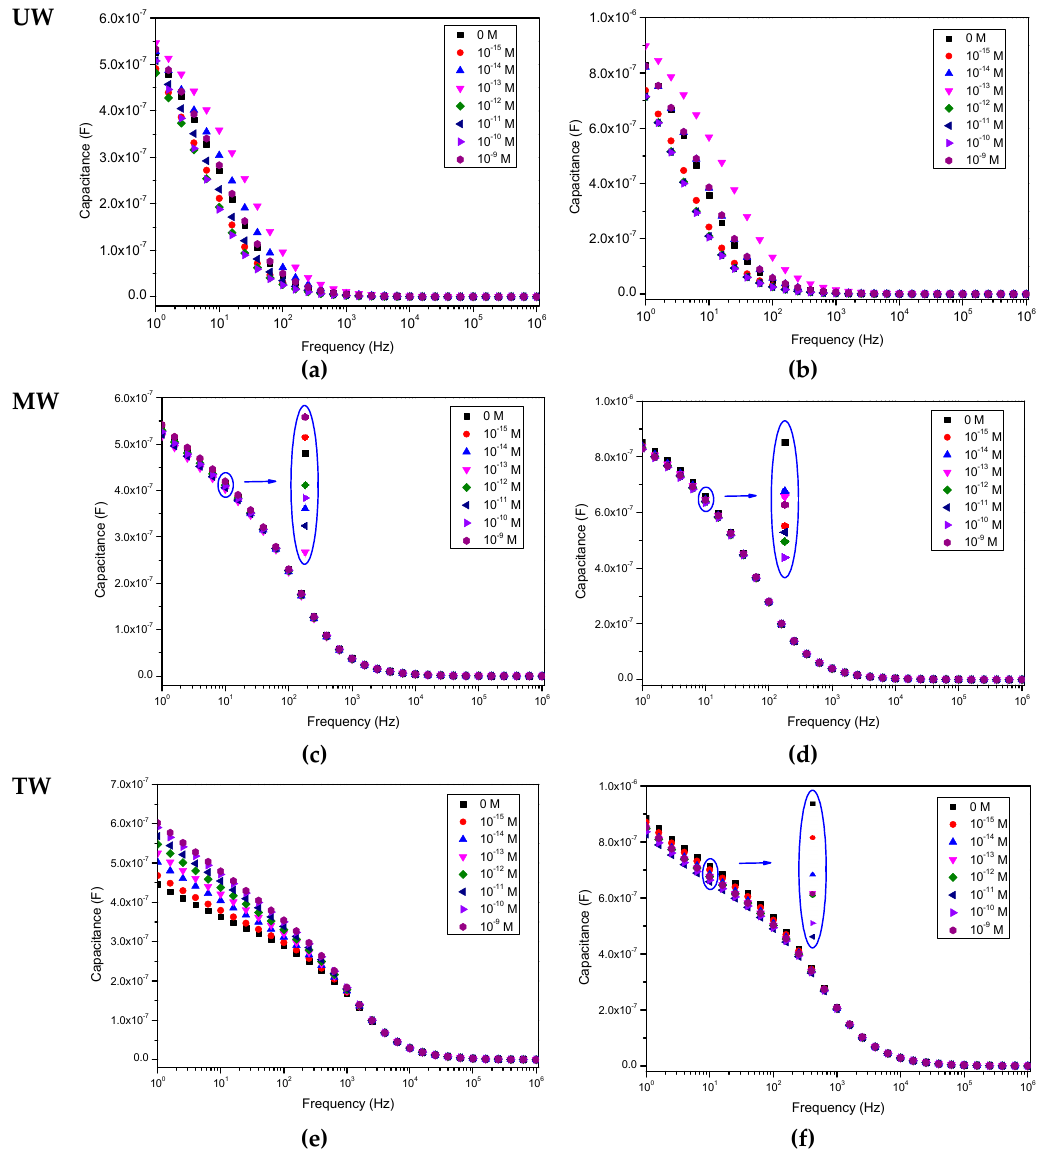
Figure 2. Capacitance spectra of the sensor devices when immersed in water solutions spiked with different EE2 concentrations: ( a ) uncoated interdigitated electrodes (IDE) in ultrapure water (UW), ( b ) IDE coated with (PEI/PSS) 5 film in UW, ( c ) uncoated IDE in mineral water (MW), ( d ) IDE coated with (PEI/PSS) 5 film in MW, ( e ) uncoated IDE in TW, ( f ) IDE coated with (PEI/PSS) 5 film in tap water (TW). Relative error is less than 1%.